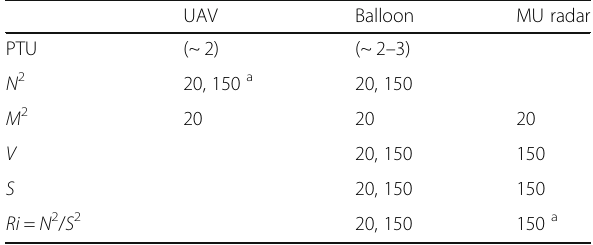
Table 1 List of atmospheric parameters measured or calculated from UAV, balloon, and radar data (resolution of the profiles are given in meters) UAV